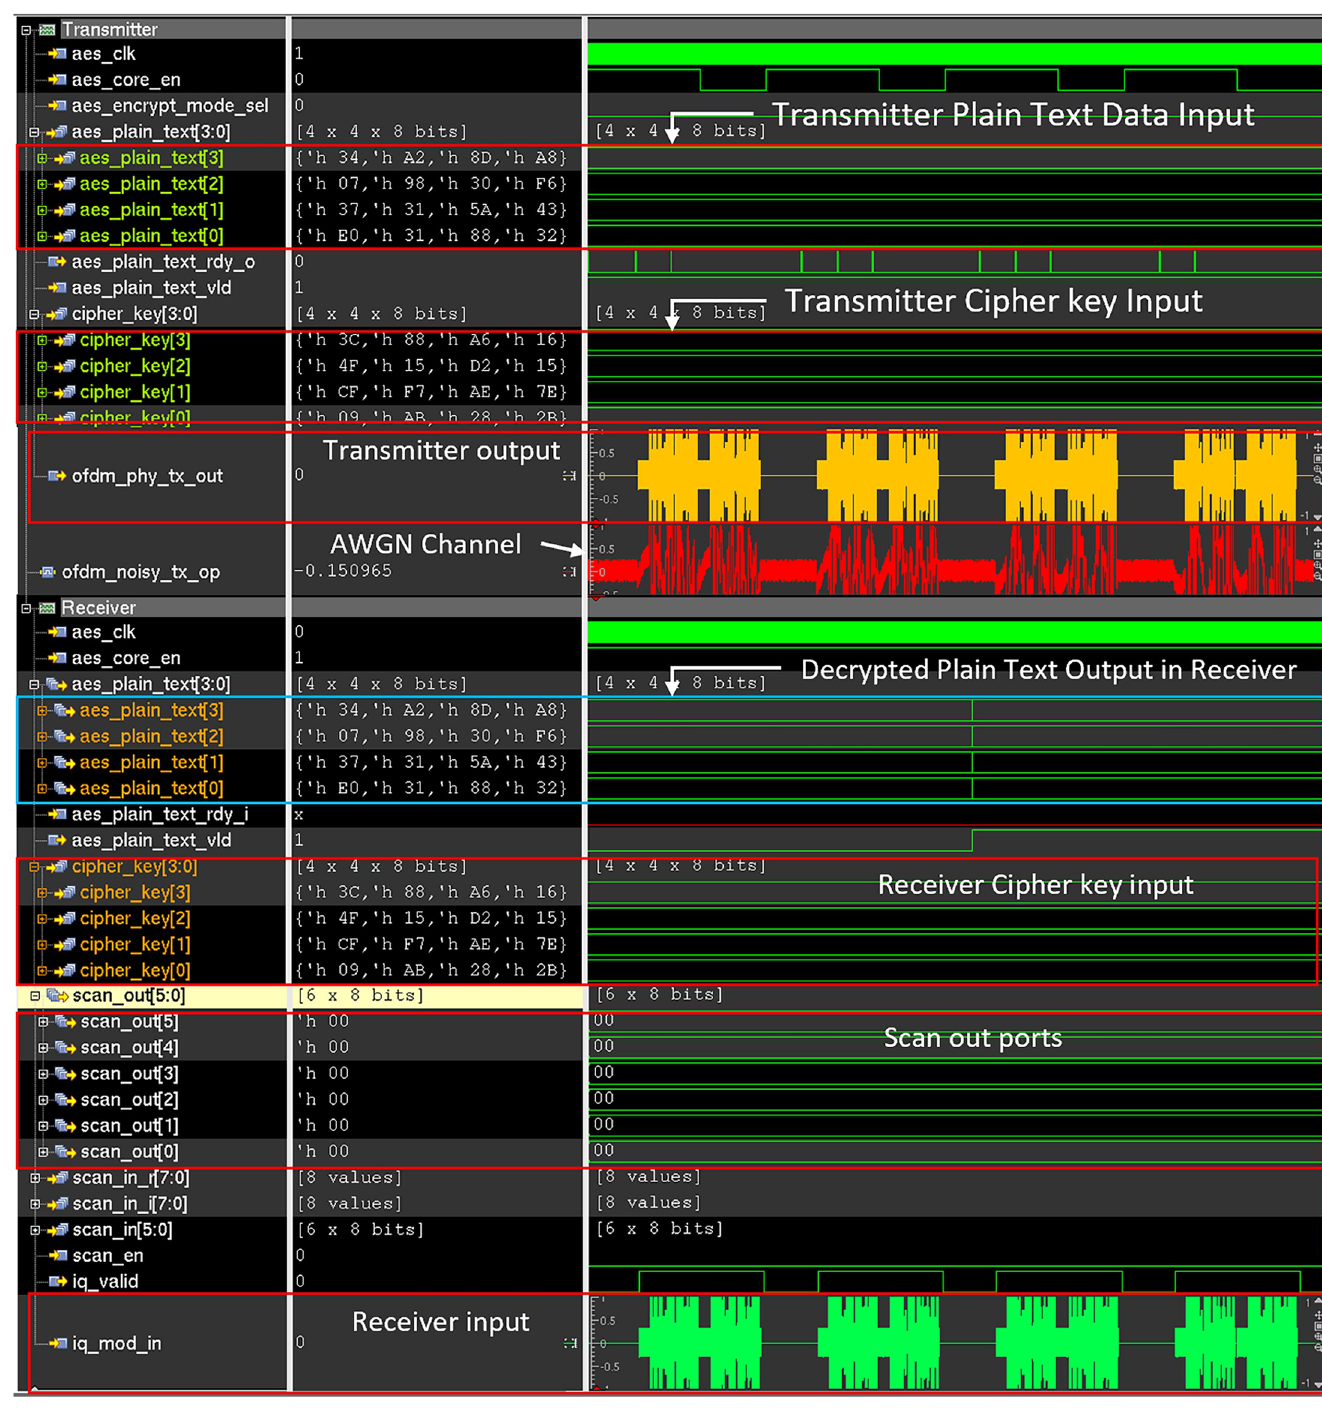
Fig 15. Simulation waveform of trojan free wireless cryptographic IC.